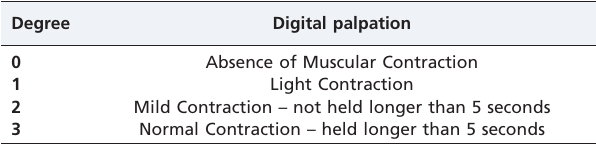
Table 1 - Subjective classification of different degrees of PFM contraction.